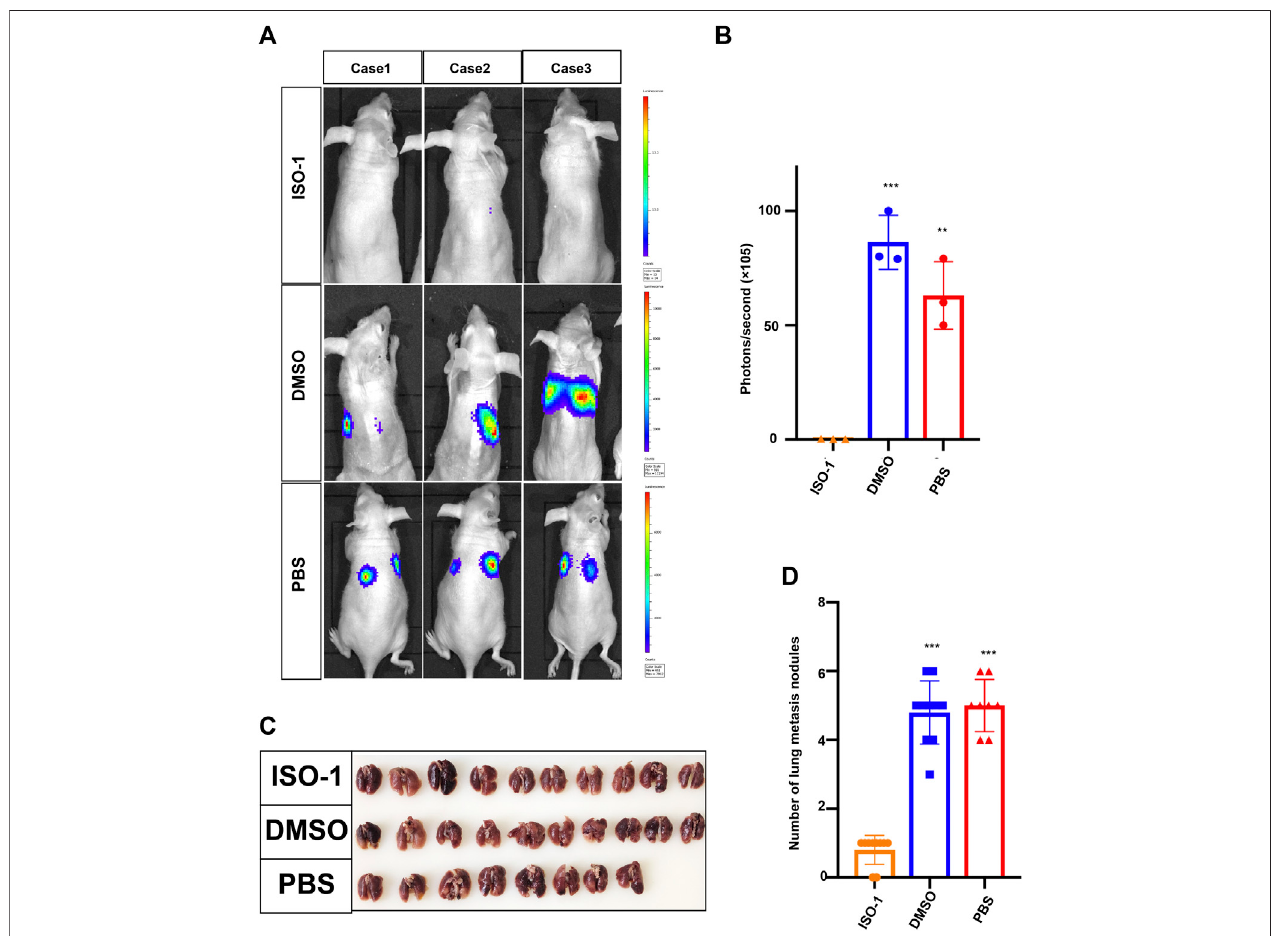
FIGURE3| MIFpromoteslungmetastasisofNPC. (A) VisualizationoflungmetastasisafterintravenousinjectionofCNE2cellsandthenseparateinjectionsofISO- 1, DMSO, and PBS into BALB/c mice. Representative images of bioluminescence signals and normalized photon fl ux are shown. (B) Graph representing the mean intensity of fl uorescence 6 weeks after tumor injection (** p < 0.01, *** p < 0.001, t-test). (C) Representative images oflung metastasis in nude mice that resulted from the injection of ISO-1, DMSO, and PBS after intravenous injection of CNE2 cells. (D) Statistical analysis of the number of lung nodules in the ISO-1, DMSO, and PBS groups (*** p < 0.001,